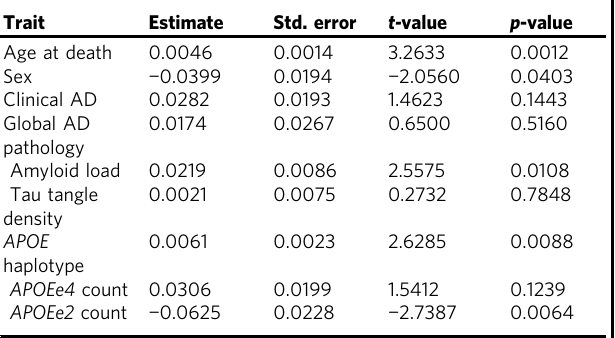
Table 1 The clinicopathological trait associations of HuMi_Aged